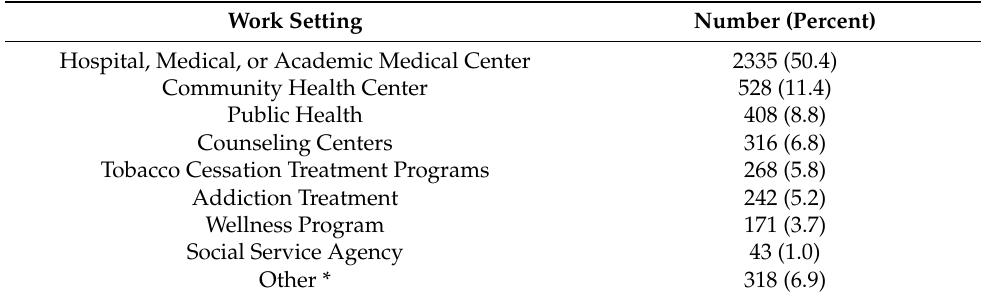
Table 5. Trainee primary work setting ( n =